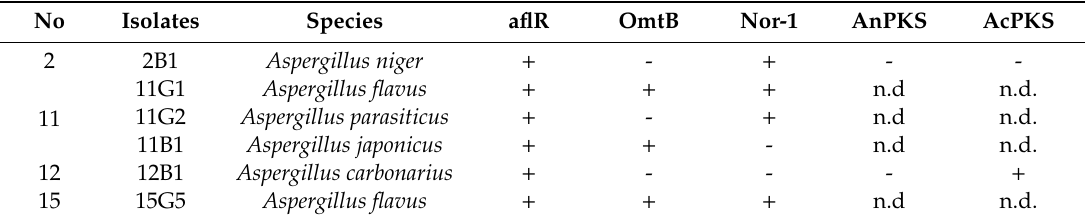
Table 4. Molecular characterization of Aspergillus strains isolated from dried and powdered chili purchased from the traditional and the modern markets.